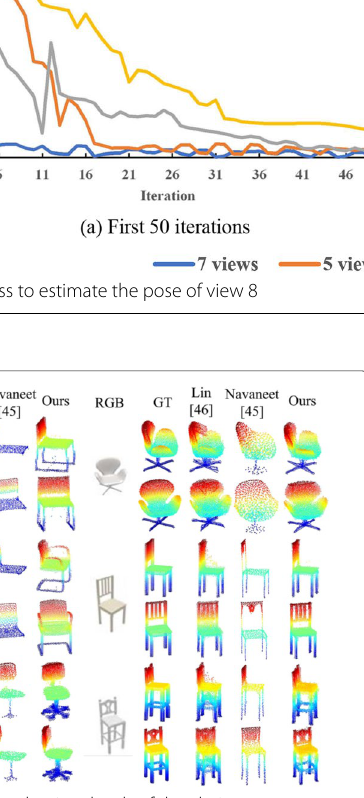
Figure 9 The reconstructed point clouds of the chair